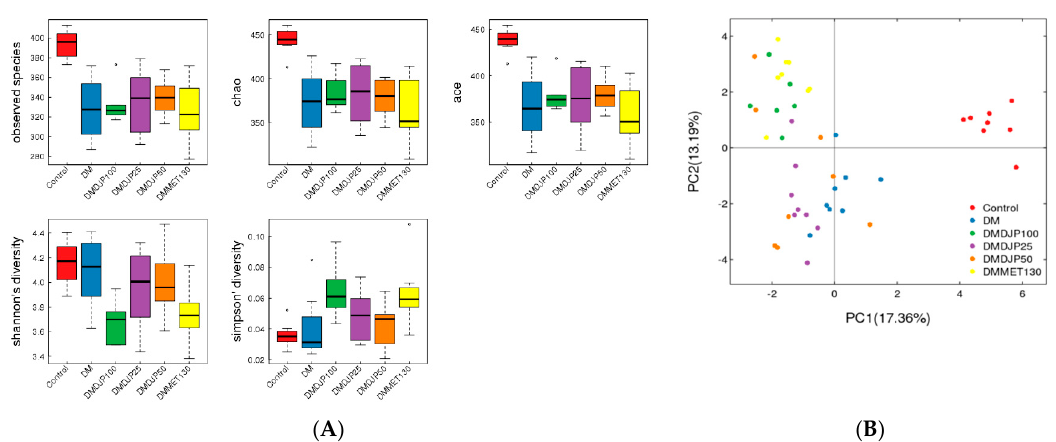
Figure 10. Alpha diversity indices box-plots and principal component analysis (PCA) plots based on operational taxonomic units (OTUs) abundance. ( A ) box-plots; ( B ) PCA